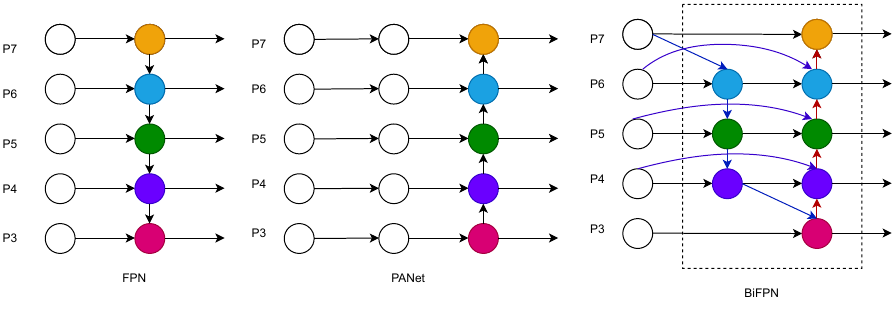
Figure 7. FPN PANet and BiFPN